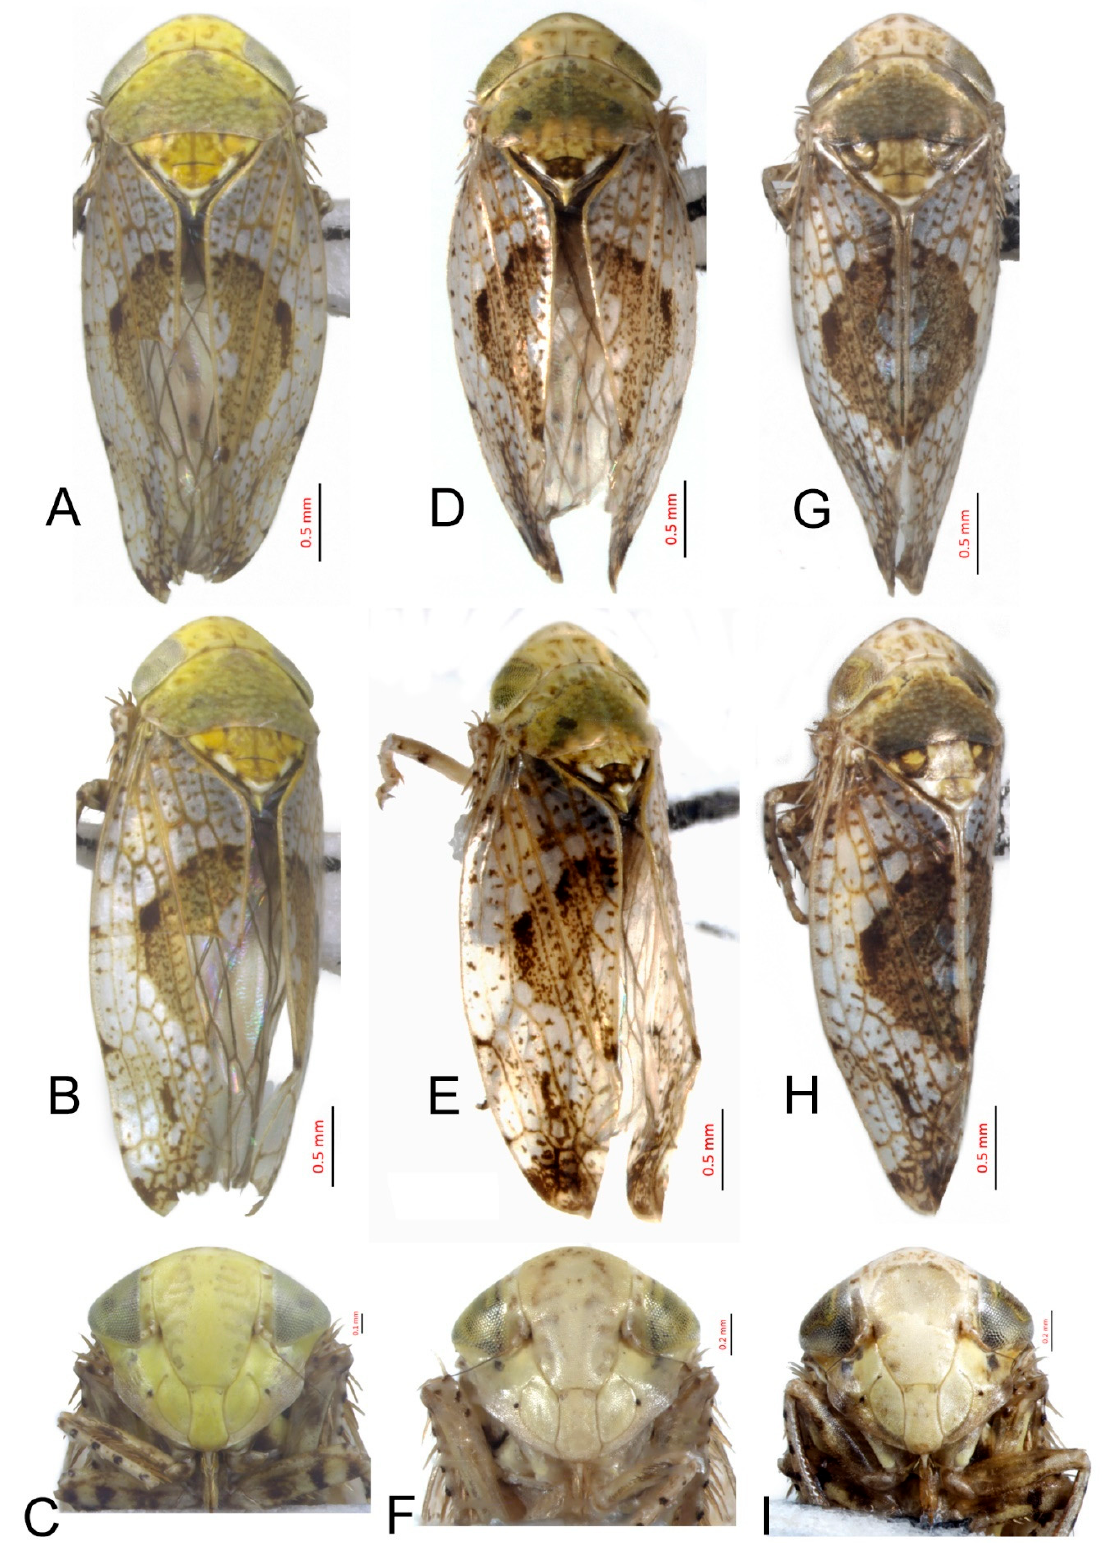
Figure 7. Species of Hishimonus . ( A – C ) H. dichotomous ; ( D – F ) H. sellatus ; and ( G – I ) H. rectus . ( A , D , G ) Dorsal view; ( B , E , H ) latero-dorsal view; ( C , F , I ) Face.